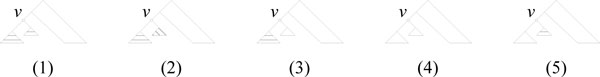
Coloring algorithm. The five steps of the coloring in the smaller-half trick.